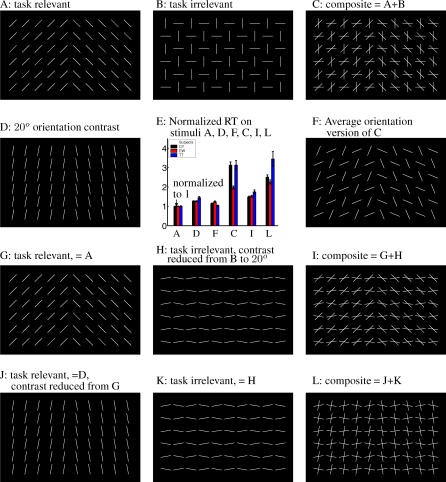
Further Illustrations To Understand Interference by Task-Irrelevant Features(A–C) As in Figure 1, the schematics of texture stimuli of various feature contrasts in task-relevant and -irrelevant features.(D) Like (A), except that each bar is 10° from vertical, reducing orientation contrast to 20°.(F) Derived from (C) by replacing each texture element of two intersecting bars by one bar whose orientation is the average of the original two intersecting bars.(G–I) Derived from (A–C) by reducing the orientation contrast (to 20°) in the interfering bars, each is 10° from horizontal.(J–L) Derived from (G–I) by reducing the task-relevant contrast to 20°.(E) Plots the normalized RTs for three subjects, DY, EW, and TT, on stimuli (A,D,F,C,I,L) randomly interleaved within a session. Each normalized RT is obtained by dividing the actual RT by the RT (which are 471, 490, and 528 ms, respectively, for subjects DY, EW, and TT) of the same subject for stimulus (A).For each subject, RT for (C) is significantly (p < 0.001) higher than that for (A,D,F,I) by at least 95%, 56%, 59%, and 29%, respectively. Matched sample t-test across subjects shows no significant difference (p = 0.99) between RTs for stimuli (C) and (L).